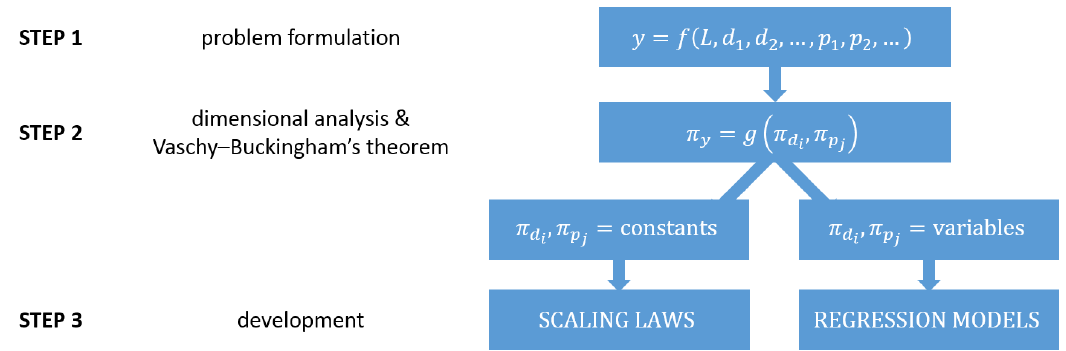
Figure 7. Estimation model development